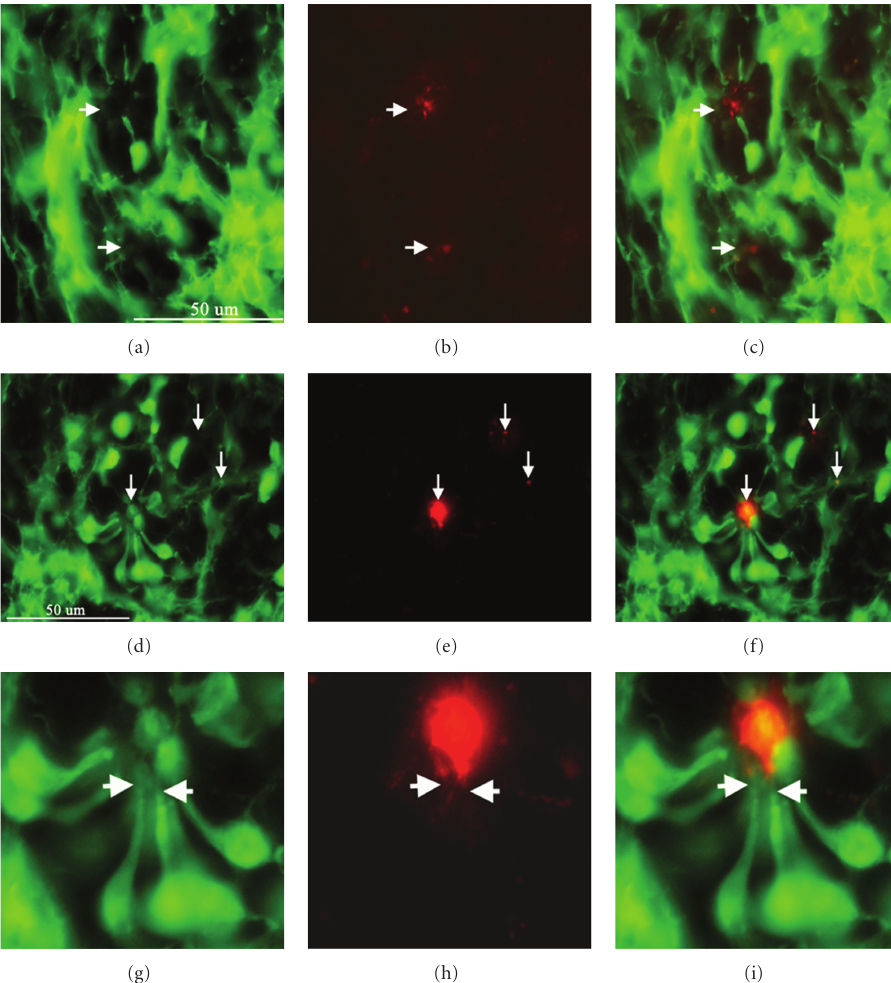
Figure 6: Expression of ROM-1 within rosettes of the graft. Recipient was 6 weeks of age at time of transplantation and experiment terminated 5 weeks later. Immunohistochemical labeling for rod outer segment marker-1. Panels in the left column of Figures (a, d, g) show endogenous GFP transgene expression (green) of donor cells, panels in the central column (b, e, h) show ROM-1 expression (red), and panels in the right column (c, f, i) show the merged images comprised of the 2 preceding panels of the same row. (a) The widespread GFP expression within the graft is periodically interrupted by rounded lacunae (arrows), where (b) ROM-1 labeling can be found. Merged image (c) shows that regions of ROM-1 labeling are encircled by inwardly directed straight processes, thereby indicating that ROM-1 corresponds to the core region of the rosettes, which is the predicted location for rod outer segments in this type of structure. These findings are corroborated by examination of another rosette (d) in which there is a greater number of GFP+ cells with photoreceptor morphology, the processes of which are directed inward toward a small central core. (e) ROM-1 labeling (arrows) predominantly localizes to the core region of the rosette. (g–i) Examination of the same rosette at higher power allows visualization of the limit of GFP expression (arrows) within some of the processes of donor-derived photoreceptor-like cells, in juxtaposition to the adjacent localization of ROM-1